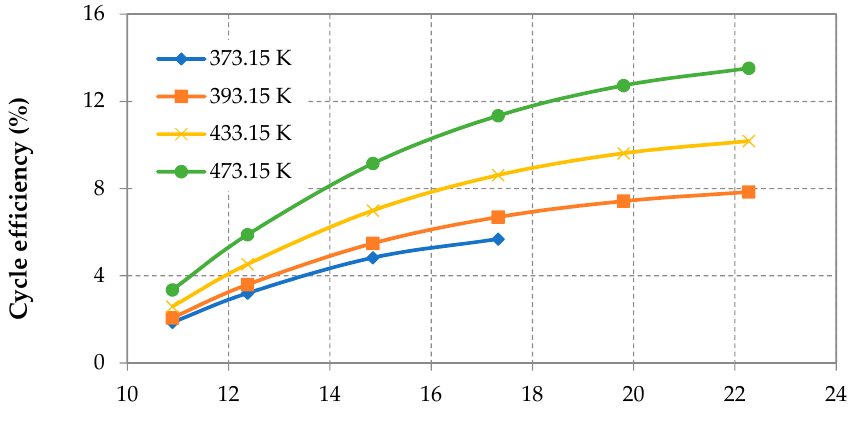
Figure 6. Relationship between turbine inlet temperature and percent of waste heat transferred to CO 2 for the different exhaust gas temperatures at the heat exchanger outlet.